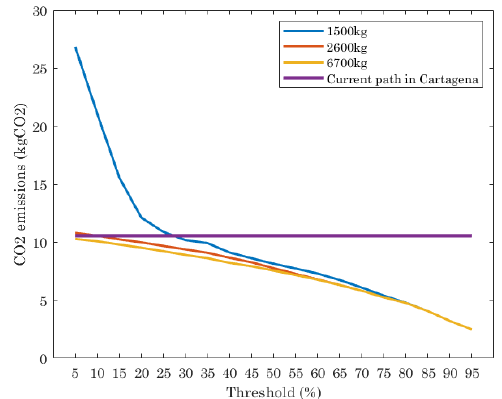
Figure 6. Amount of CO 2 emissions: for the optimal paths given by ILP and the current path in Cartagena.